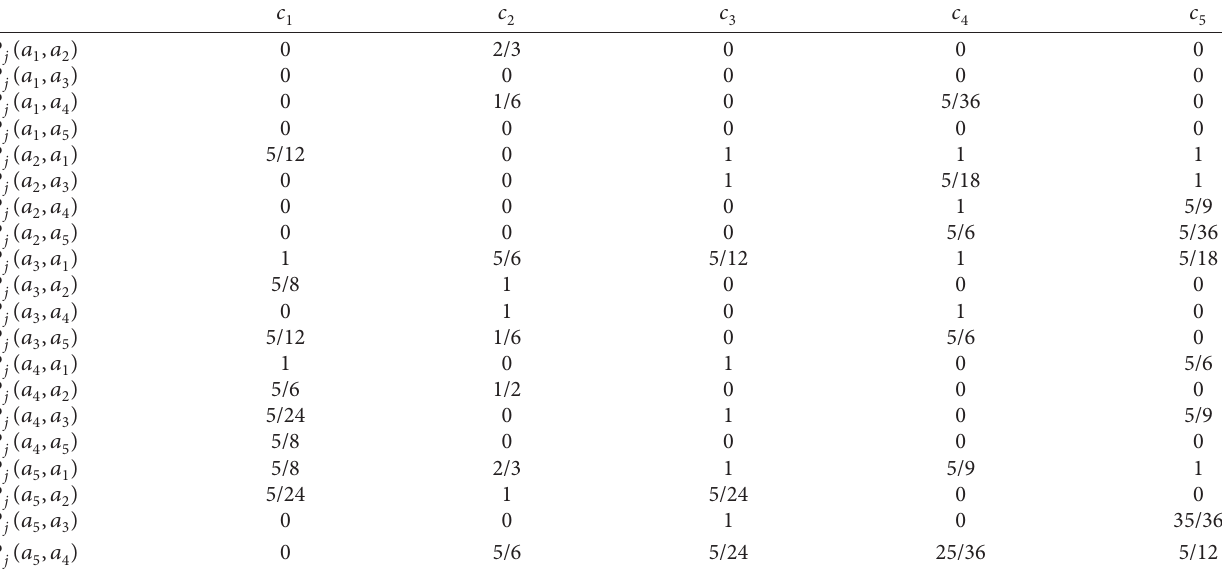
Table 2: Economic criteria dispersion.